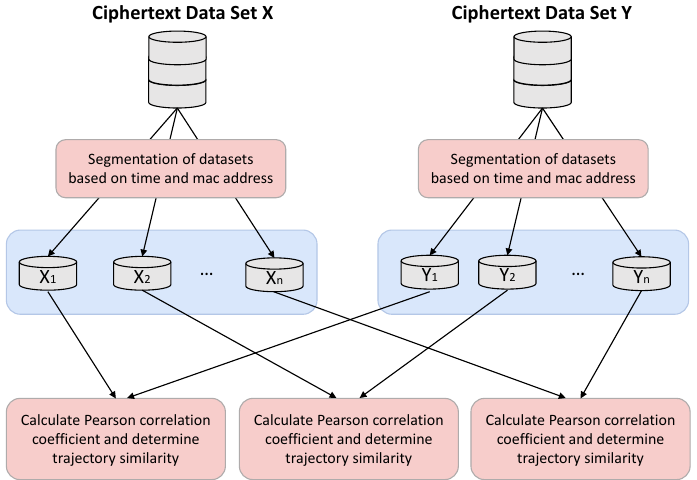
Figure 4. Segmentation Calculation Process for Determining the Similarity of